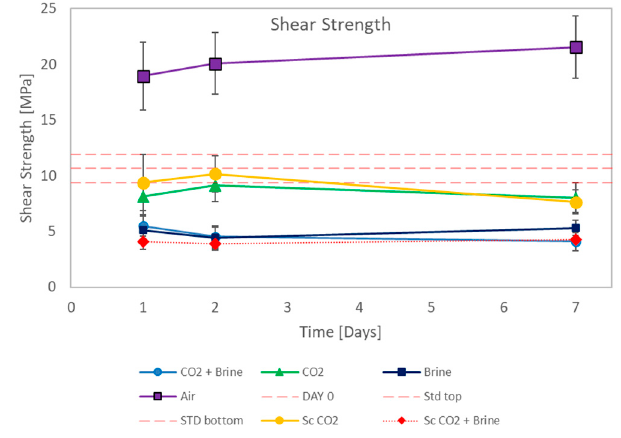
Figure 6. Shear strength results from the punch testing campaign. The dashed horizontal lines show the values (measured plus minus standard deviation) for the reference shale samples, tested as is.